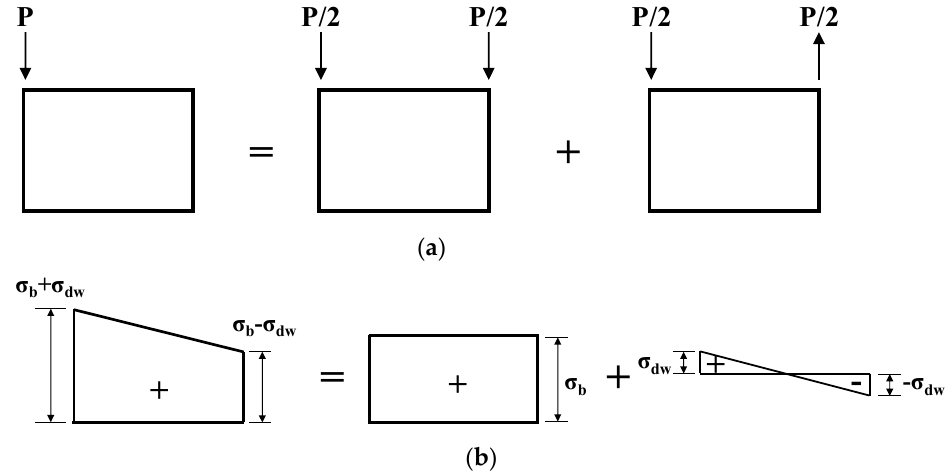
Figure 7. Decomposition of the loads and normal stress components of box section. ( a ) Eccentric loads acting on box girder sections, and ( b ) normal stress components acting along the flange width.